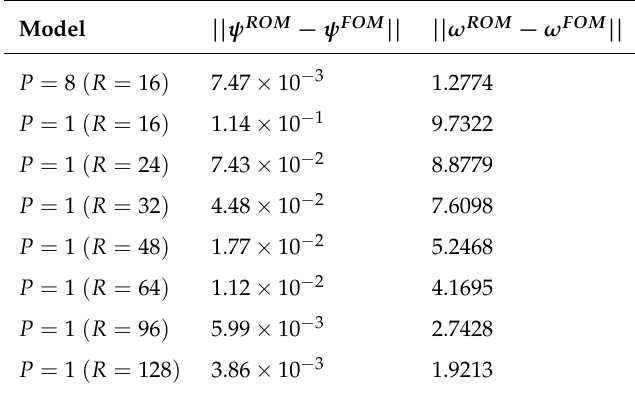
Table 1. Root-mean-squares error at time t = 4 between Galerkin ROM (without any additional stabilization κ = 0) and FOM at Re =